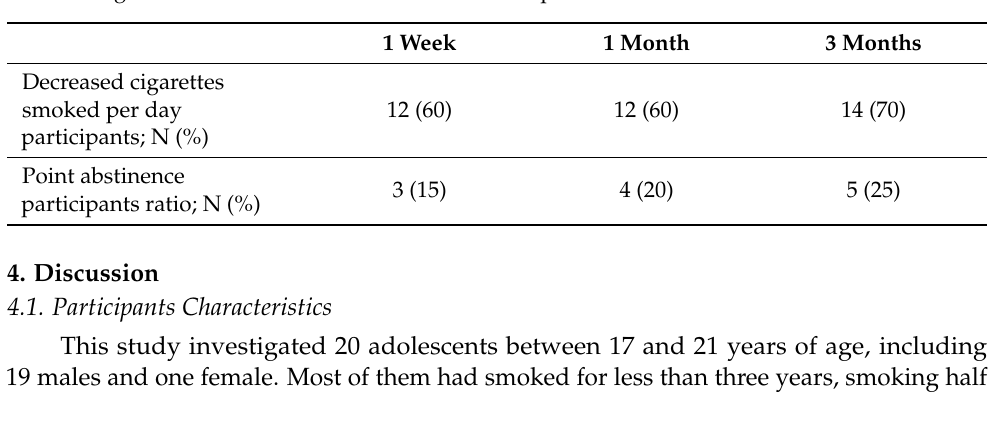
Table 4. Cigarette smoke amount decreased ratio and point abstinence